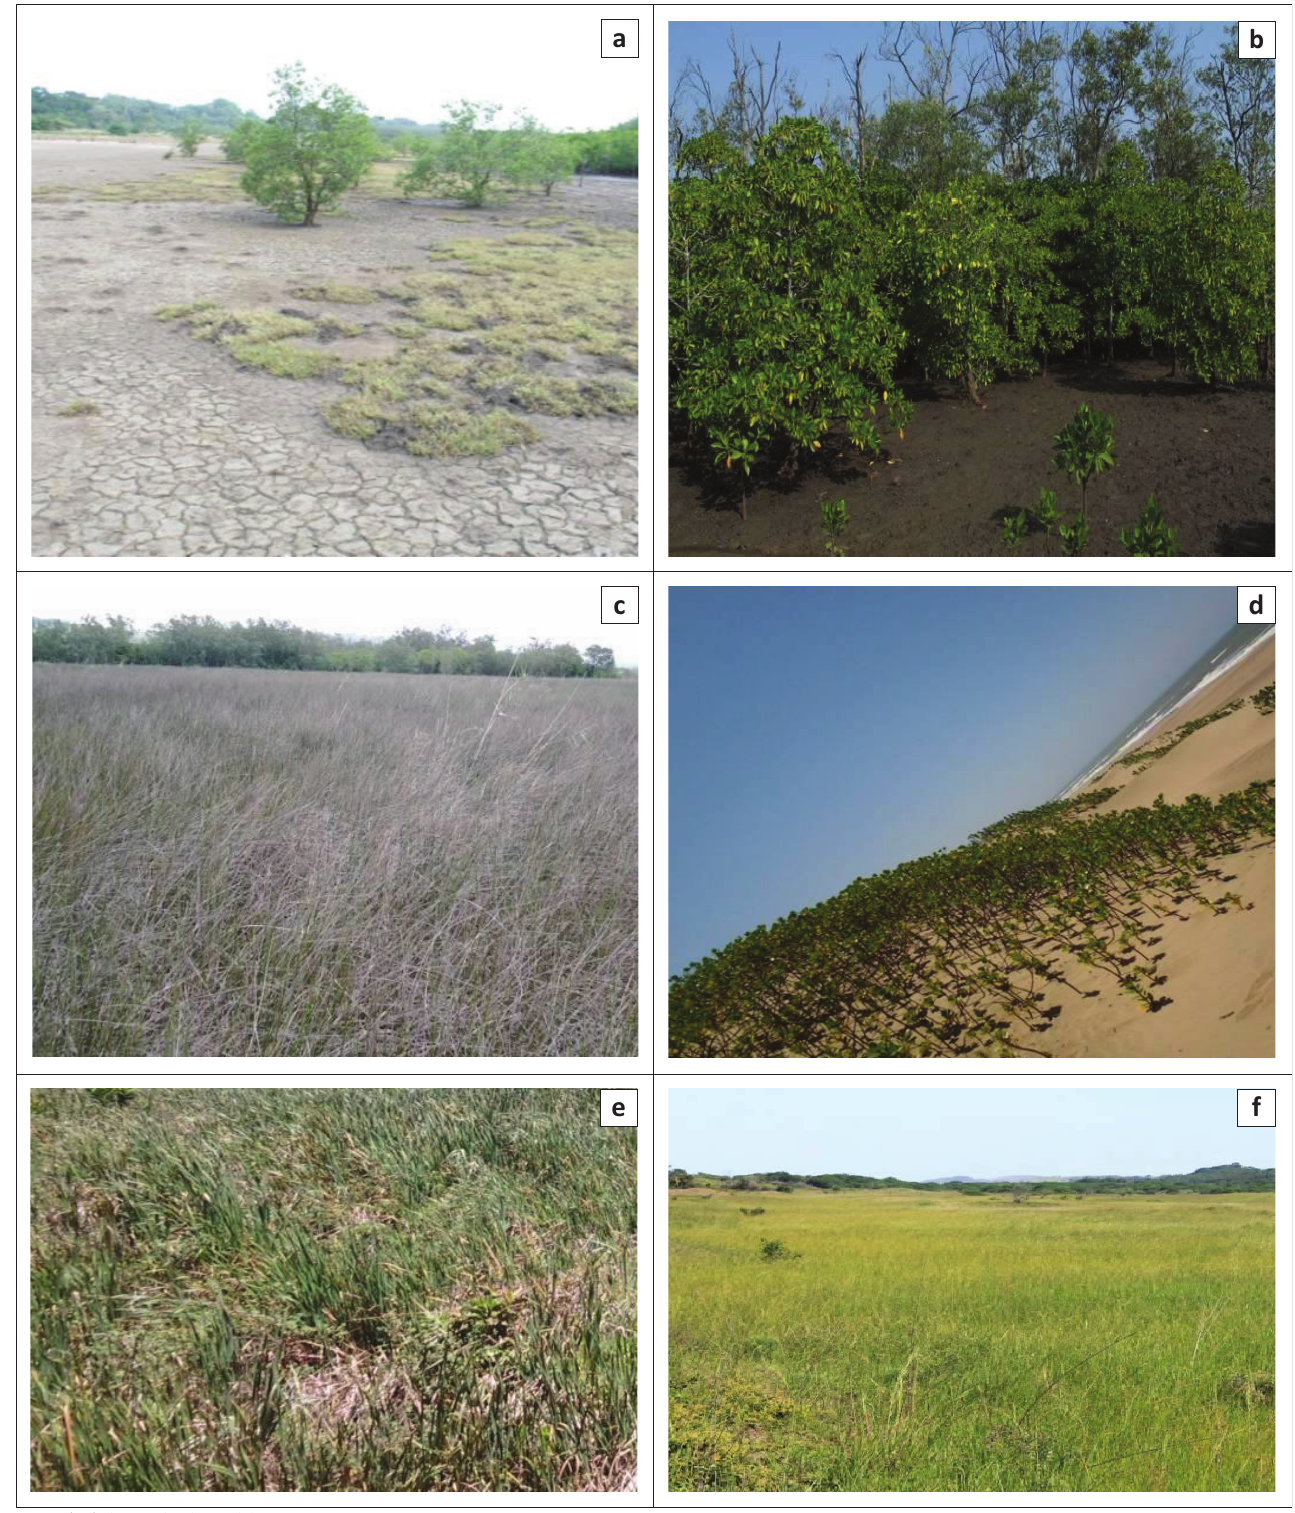
FIGURE 3: Representative photographs of the uMlalazi Nature Reserve plant communities: (a) Salicornia meyeriana–Avicennia marina salt marsh community, (b) Bruguiera gymnorrhiza–Avicennia marina mangrove forest, (c) Phragmites australis–Juncus kraussii saline wetland, (d) Scaevola plumieri–Gazania rigens foredune community, (e) Typha capensis–Cyperus dives wetland community, (f) Digitaria eriantha–Dactyloctenium australe secondary coastal grasslands, (g) Stenotaphrum secundatum– Phragmities australis freshwater wetland, (h) Passerina rigida–Carpobrotus dimidiatus dune scrub community, (i) Adenopodia spicata–Vachellia robusta riverine woodland community, (j) Albizia adianthifolia–Chromolaena odorata disturbed coastal dune forest, (k) Tricalysia sonderiana–Apodytes dimidiata dune forest margin, (l) Gymnosporia arenicola–Protorhus longifolia coastal dune forest, (m and n) Carissa bispinosa–Mimusops caffra climax coastal dune forest. Figure 3 continues on the next page